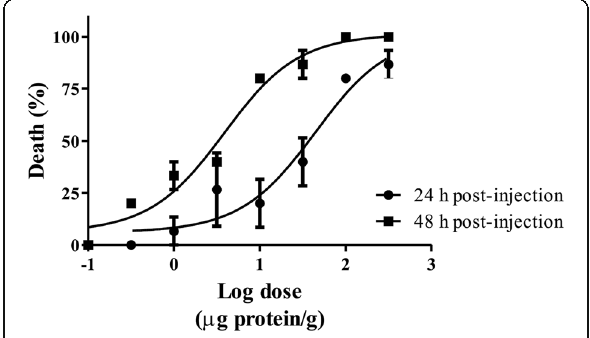
Fig. 3 Toxicity of P. caribaeorum venom on crickets ( A. domestica ) at 24 and 48 h